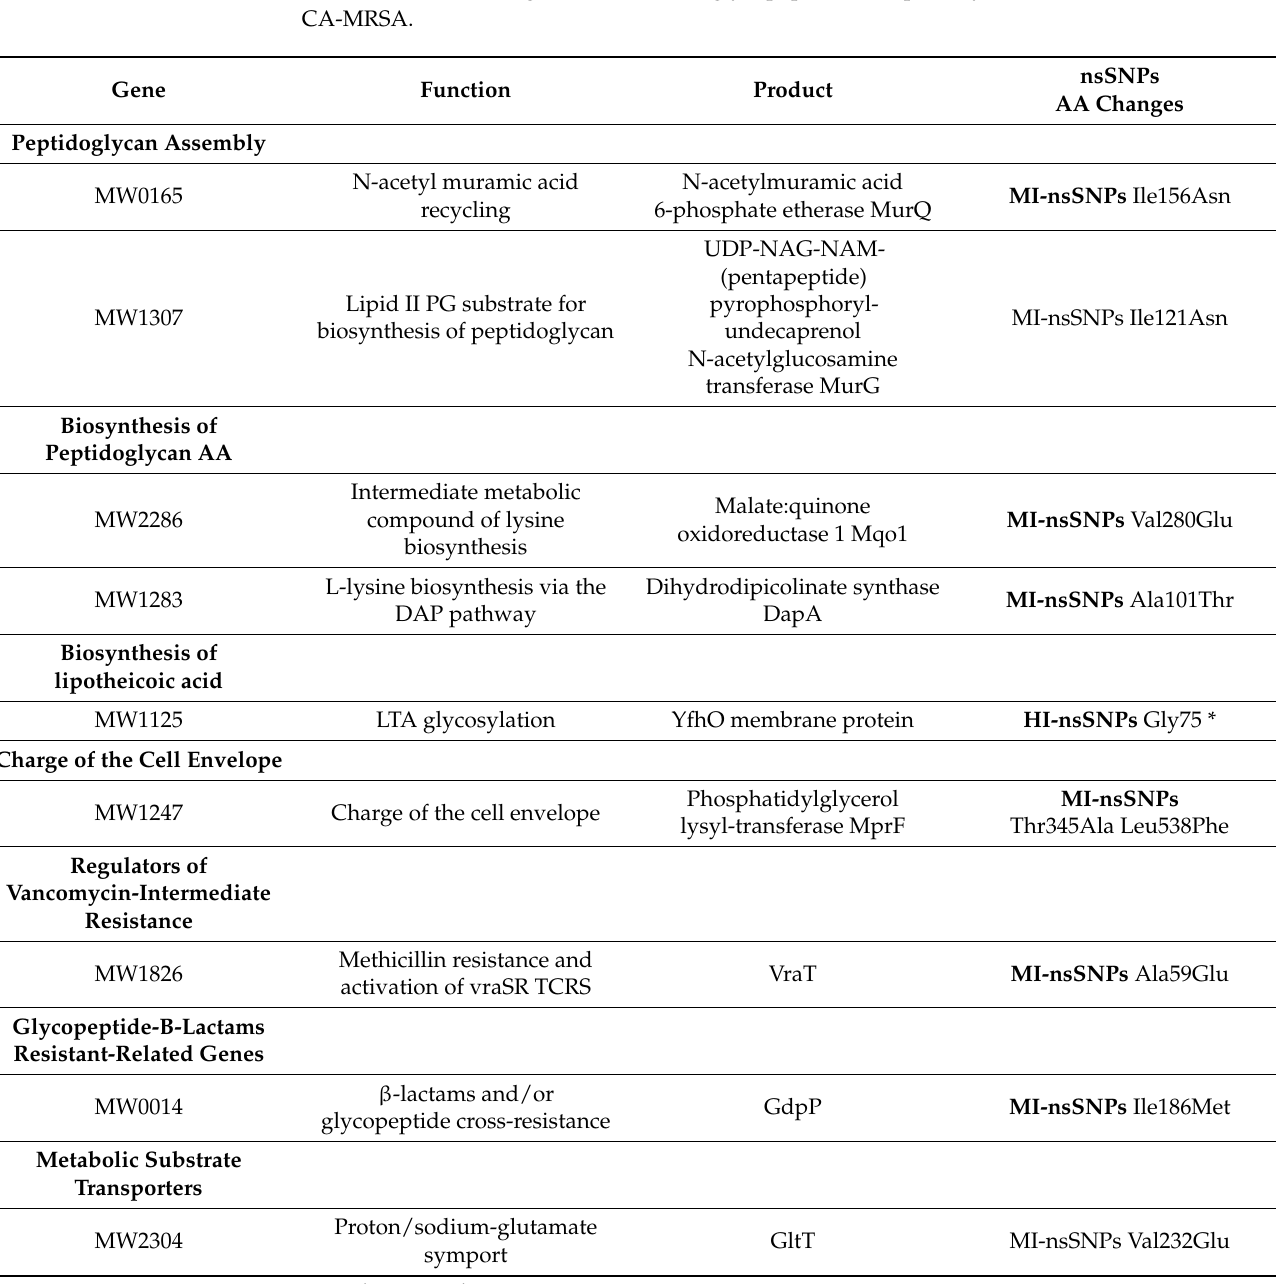
Table 1. nsSNPs in targets with reduced glycopeptide susceptibility in VISA CA-MRSA vs. VSSA